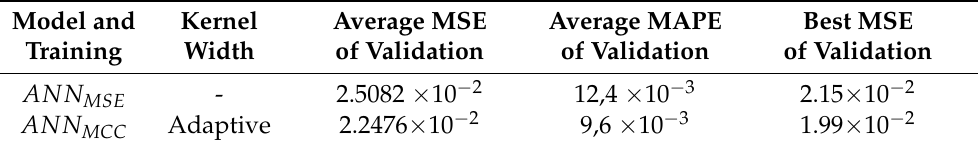
Table 6. Performance comparison of ANN models. State of Charge—Training result without the pres- ence of noise or outliers—Dynamic Stress Test.